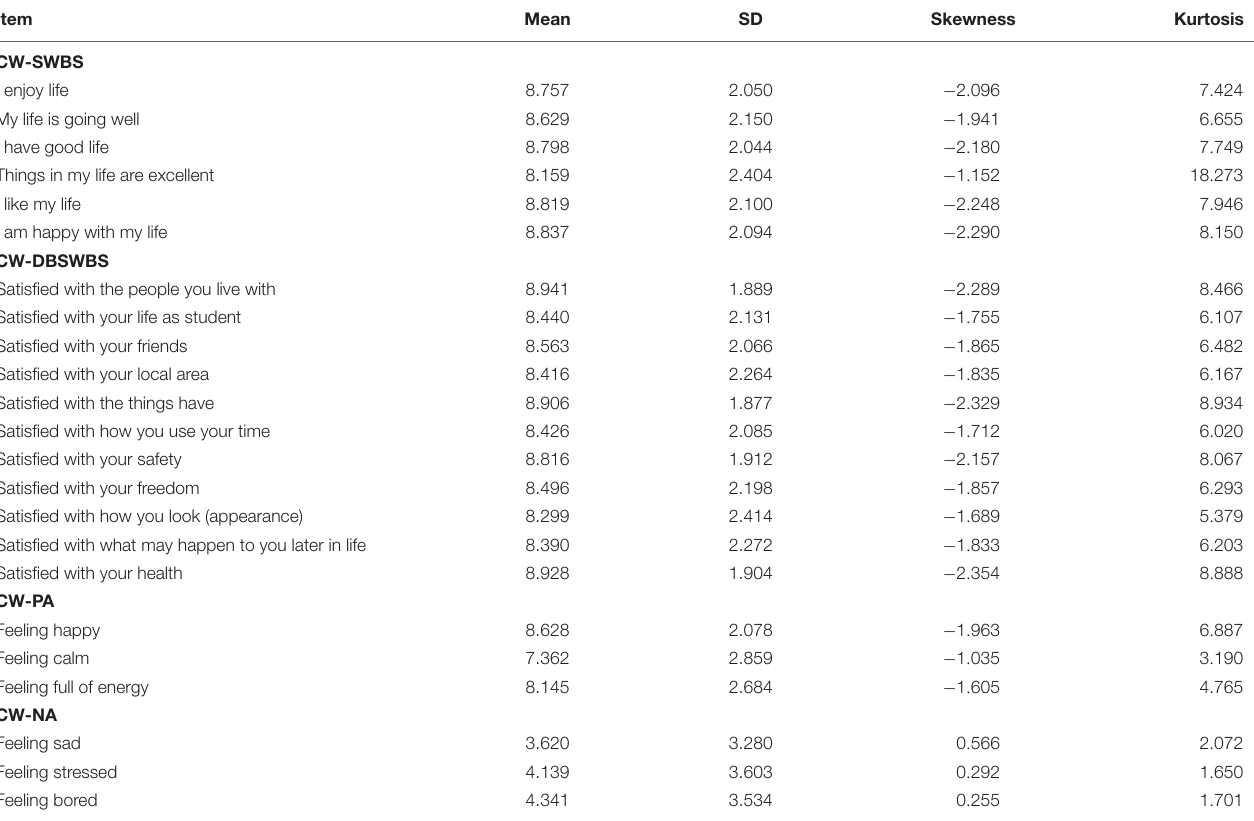
TABLE 1 | Item means and standard